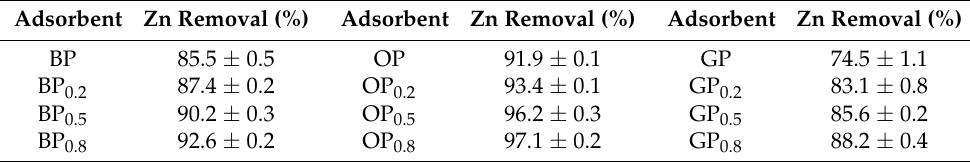
Table 2. Zn removal percentage achieved with bio-adsorbents.